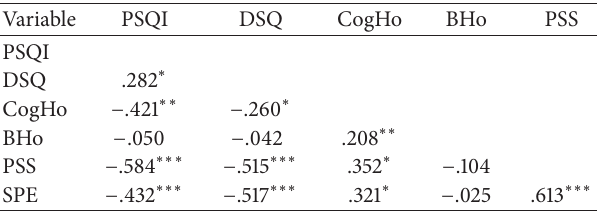
Table 1: The pearson correlations.